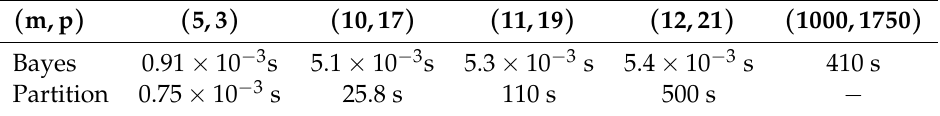
Table 1. Computational time comparative between inference Bayes algorithm and naive algorithm (Equation (10)) with different network size ( m = | N | , p = | A | ). Algorithms has been executed on a computer with an Intel Core i7 processor and 8gb